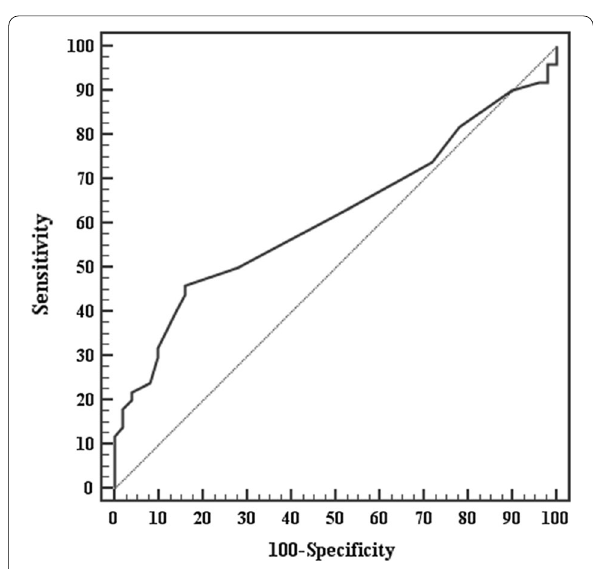
Fig. 1 Receiver operating characteristics (ROC) curve. Receiver operating characteristics (ROC) curve was used to define the best cut‑off value of vitamin D that was 19 ng/ml, with sensitivity of 46% ≤ %, specificity of 84%, positive predictive value of 74.2% and negative predictive value of 60.9%, with an area under the curve (AUC) of 0.616, P <